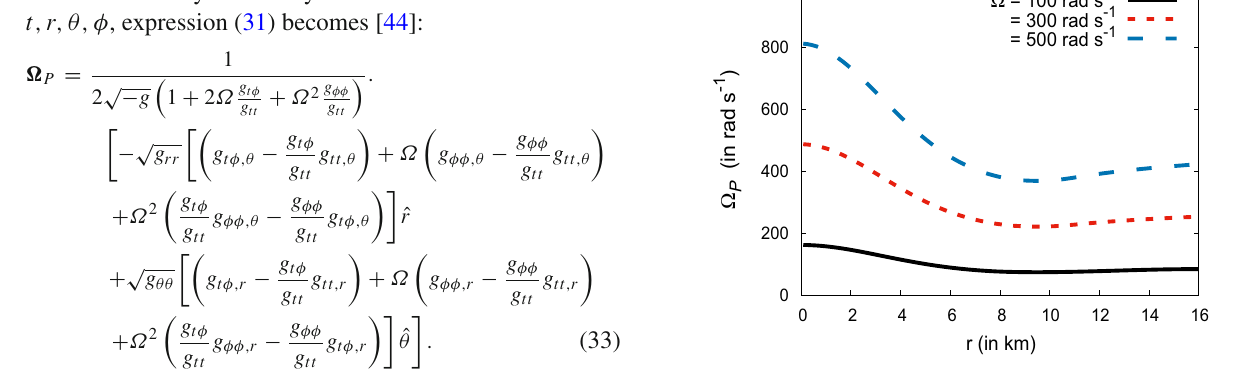
Fig. 5 Variation of Ω P with distance from centre along the equatorial plane orbiting around spherically symmetric star with central energy density of 1 . 0 × 10 15 g cm − 3 . Curve for three value of Ω are shown in the figure, starting from lower (black solid curve) to as high as 500 rad s − 1 (blue dashed curve). The frequency in Hz can be calculated as: f = Z , where Z cab be Ω , Ω P or ω in rad s − 1 2 π